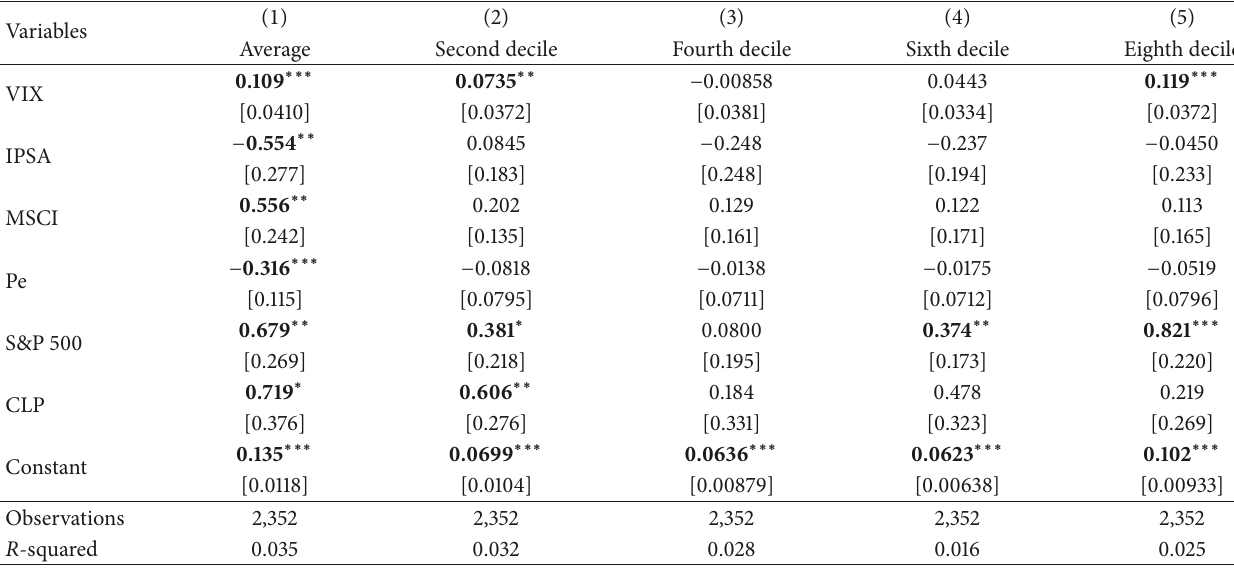
Table 2: Basic model using different thresholds. This table summarizes the results of the following basic model: 𝑦 𝑡 = 𝛼+𝛽∗𝑋 𝑡 +𝑚 𝑡 +𝑁 𝑡 +𝜀 𝑡 . The dependent variable is the proposed index of network change for different thresholds that define a link. 𝑋 𝑡 corresponds to the returns or growth rate of variables such as IPSA, VIX, Pe, S&P 500, CLP, and MSCI. 𝑚 𝑡 and 𝑁 𝑡 are month and year fixed effects to control for seasonality and variation associated with any specific year. Column (1) uses the average transaction as a threshold. Columns (2) to (5) use the second, fourth, sixth, and eighth deciles as thresholds.